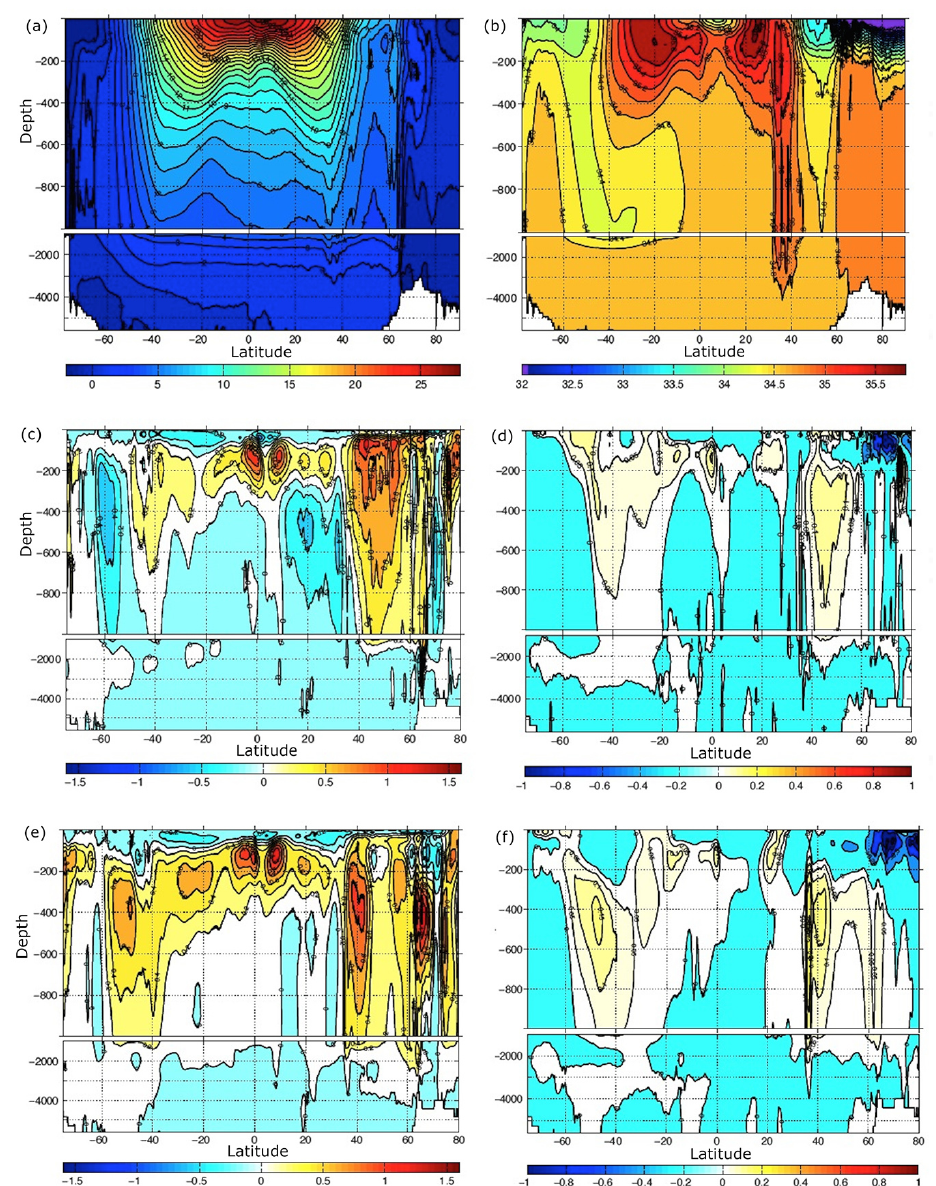
Figure 2. (a, b) GLOB16 zonal mean temperature (left column) and salinity (right column) in years 2009–2013 and (c, d) differences with EN3 data set. (e, f) As panels (c, d) but for GLOB4. Black and Caspian seas are not considered in the zonal mean. The contour interval is 1 ◦ C in panel (a) , 0.2 ◦ C in panels (c, e) , 0.2psu in panel (b) , and 0.05psu in panels (d, f)